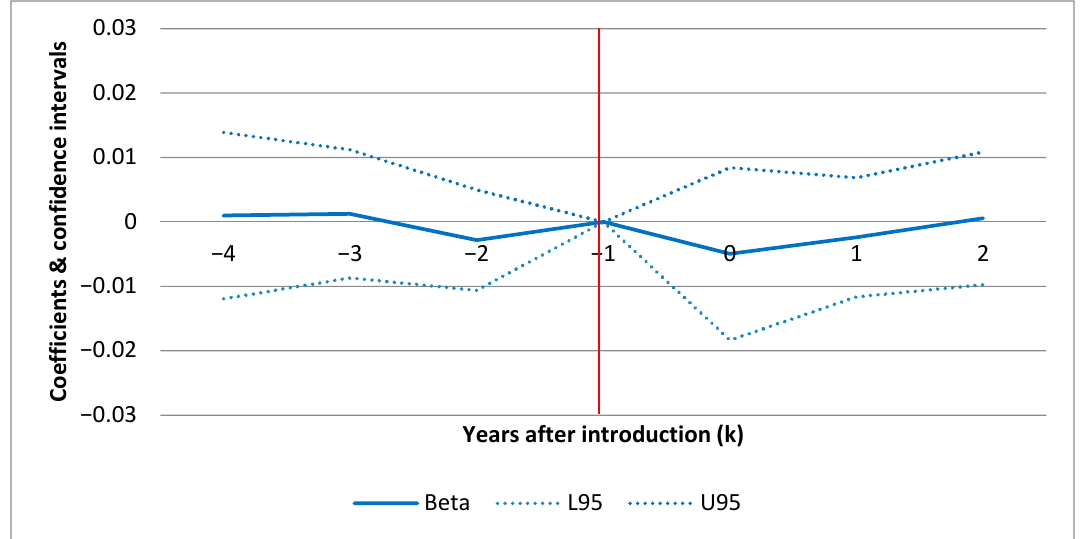
Figure 2. Yearly effects of POCT of HbA1c on ambulatory care sensitive diabetes condition (ACSCs) admissions, point estimates. Note: The dotted lines represent 95% confidence intervals. The model includes year and clinic fixed effects and the full set of covariates from Table 6.